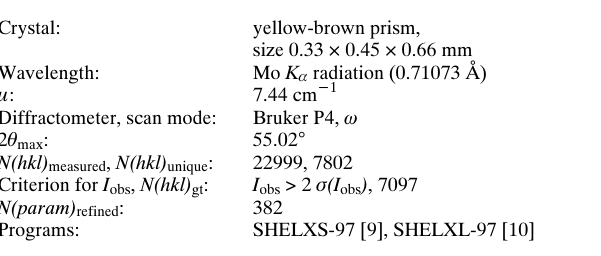
Table 1. Data collection and